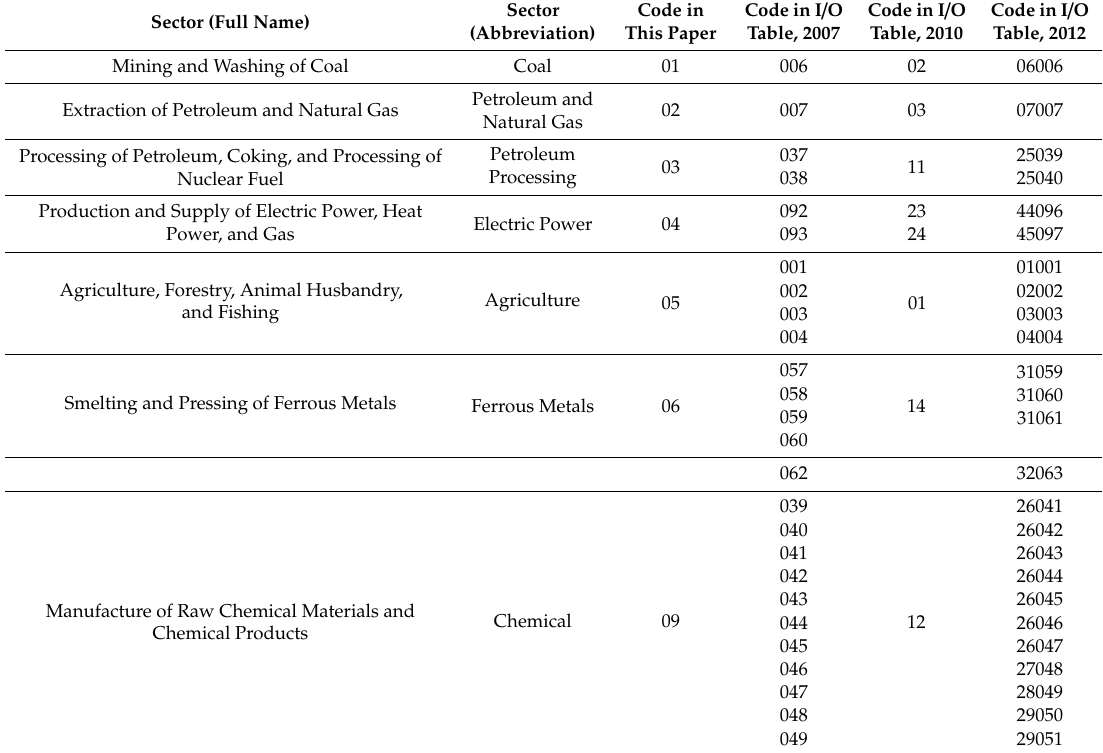
Table A1. Sector